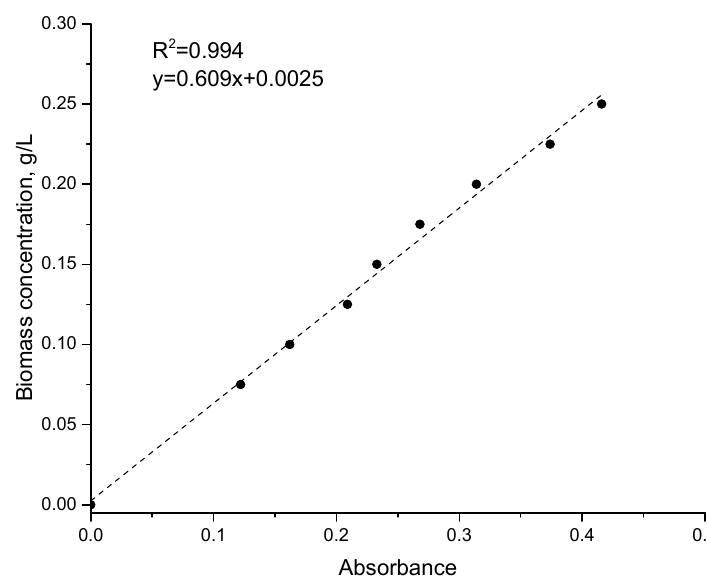
Figure 1. Correlation between the absorbance at 620 nm of a living biomass suspension of spirulina and the mass of the cell fraction.